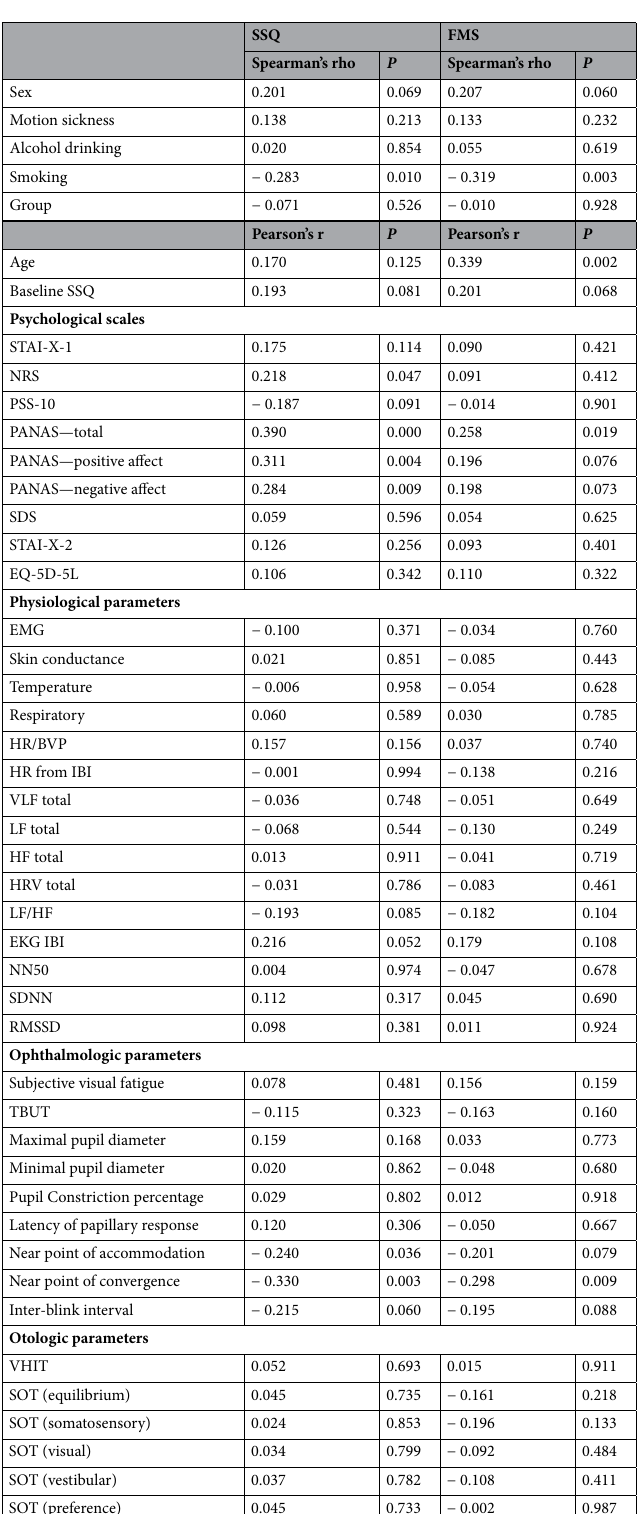
Table 3. Correlation analysis. SSQ Simulator Sickness Questionnaire, FMS Fast Motion sickness Scale, STAI State-Trait Anxiety Inventory, NRS Numeric Rating Scale, PSS-10 Perceived Stress Scale, PANAS Positive and Negative Affect Schedule, SDS Sheehan Disability Scale, EQ-5D-5L Five-level version of EQ-5D, EMG electromyography, HR/BVP heart rate/blood vessel pressure, IBI inter-beat interval, VLF very low frequency band, LF low frequency band, HF high frequency band, HRV heart rate variability, NN50 number of interval differences of successive normal-to-normal (NN) intervals greater than 50 ms, SDNN standard deviation of NN, RMSSD the root mean square of the successive differences, TBUT tear breakup time, VHIT video head impulse test, SOT sensory organization